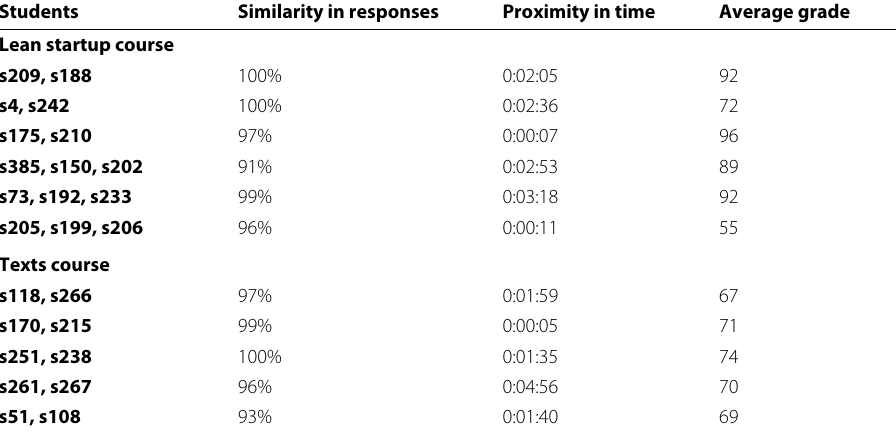
Table 1 Similarities in responses and the closeness of submissions in